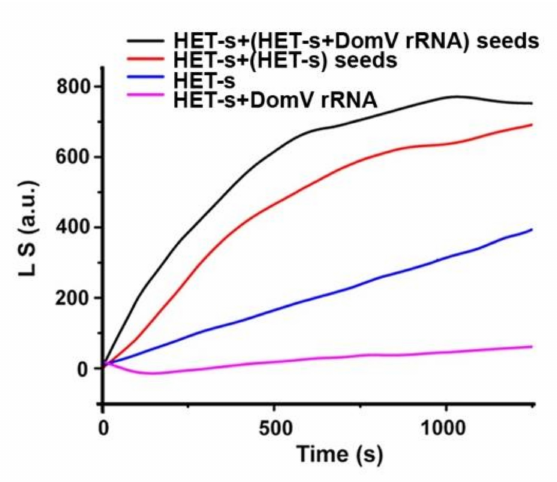
Figure 3. TEM images of HET-s without ( A ) or with ( B – D ) di ff erent RNAs. HET-s protein stored in urea was diluted to 5 µ M and incubated in 50 mM Tris-HCl pH 7.5 at 37 ◦ C for a day without or with 1 µ M in vitro transcribed domain V of E. coli 23S rRNA ( B ), DHFR mRNA ( C ) and HCA mRNA ( D ). Then, TEM images were produced using a Hitachi H-7100 transmission electron microscope (Hitachi, Tokyo, Japan).